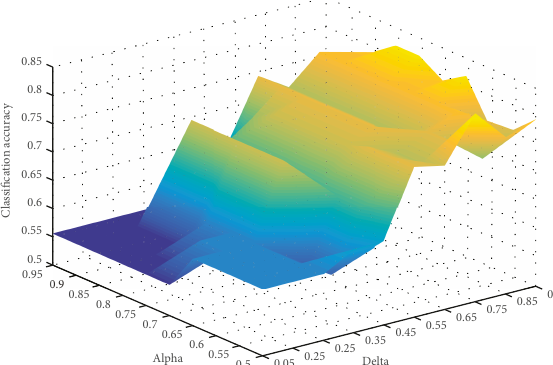
Figure 4: Classi fi cation accuracy with δ and α on heart.